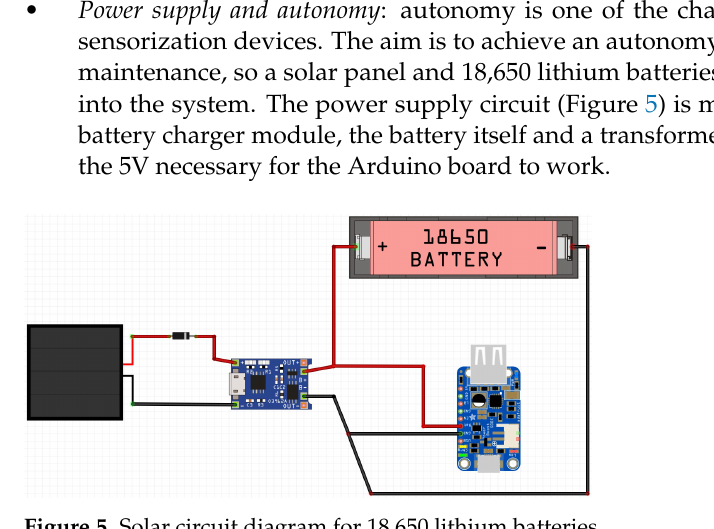
Figure 5. Solar circuit diagram for 18,650 lithium batteries.